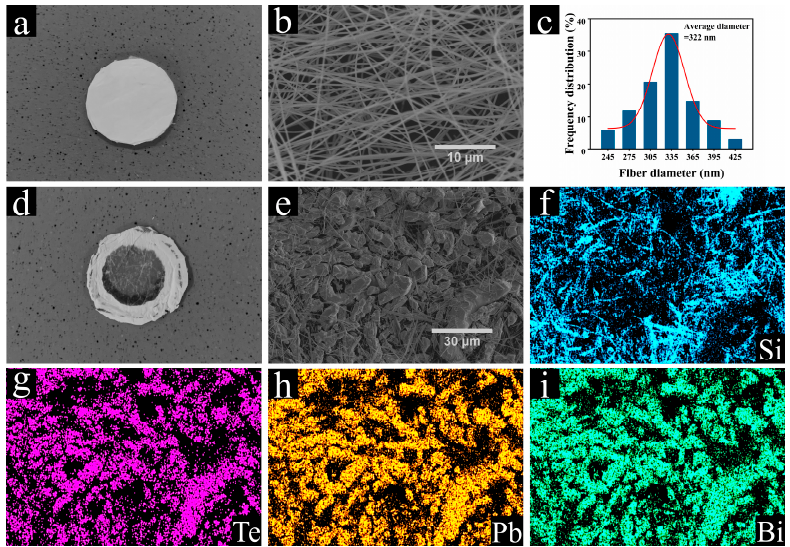
Figure 3. Photographs and scanning electron microscopy (SEM) images of SiO 2 nanofiber membrane ( a , b ) before and ( d , e ) after the Te capture experiment at the filtration temperature of 400 °C, respec- tively. ( c ) Fiber diameter distribution of the SiO 2 nanofibers and energy-dispersive X-ray spectroscopy (EDS) elemental mappings of ( f ) Si, ( g ) Te, ( h ) Pb, and ( i ) Bi are also presented.